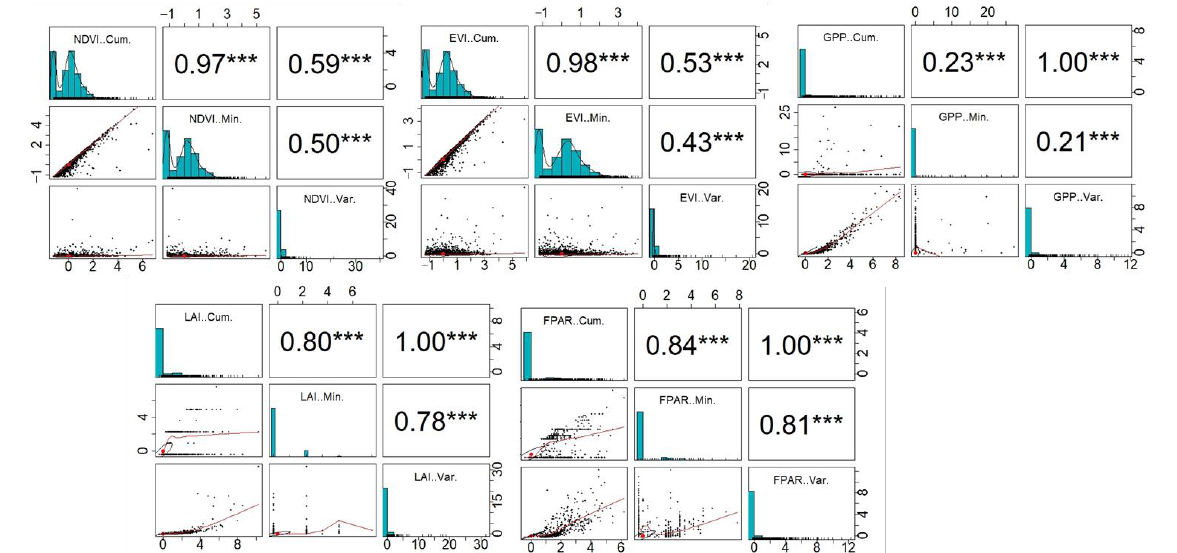
Figure 2. Spearman rank correlations and scatter plots among the three DHIs derived from the five MODIS products. It represents a correlation matrix for cum – min – var with scatter plots on one side of the diagonal and correlations on the other side. Significant relations: *** p < 0.001. The DHI correlations from different vegetation datasets were uneven. Some of corre- lations were also nonlinear (Figure 2). The Spearman rank correlations of the same vege- tation products (e.g., NDVI- and EVI-based DHIs) were higher than the ones between the DHIs based on different vegetation products (e.g., FPAR- and GPP-based DHIs). The highest correlations values were noticed between the FPAR- and LAI-based DHIs (from 0.78 for the minimum DHI to 1 for the cumulative and variation DHI). The correlations